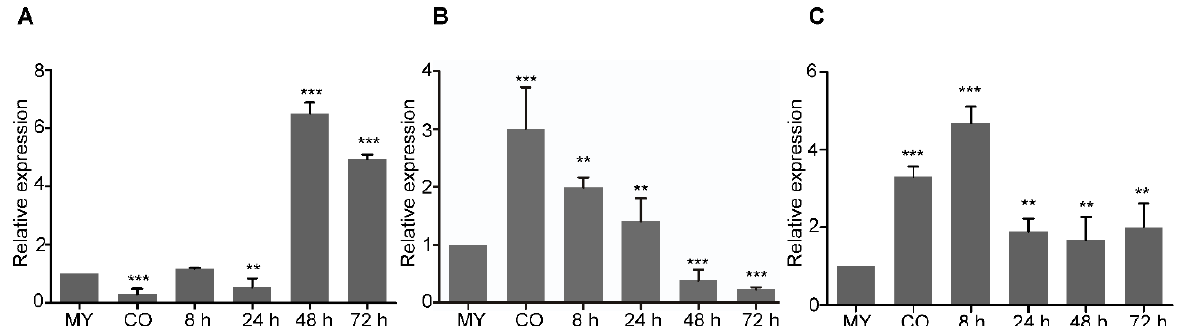
Figure 2. Phase-specific expression of the three MoGLN genes at various development stages of M. oryzae . ( A ) phase- specific expression of MoGLN1; ( B ) phase-specific expression of MoGLN2; ( C ) phase-specific expression of MoGLN3 . The phase-specific expression of the three MoGLN genes was quantified by quantitative real-time (QRT)-PCR after synthesis of cDNA in each developmental stage. The ACTIN gene (MGG_03982) was used for internal control for normalization, and the expression level of each gene at the mycelial stage was considered 1 for further comparisons. The qPCR results were obtained from three independent biological replications with three technical replicates. Error bars represent standard deviations. Asterisks indicate statistically significant differences (**, p < 0.01; ***, p < 0.001; one-way ANOVA was used to analyze data with Tukey’s multiple-comparison test in GraphPad Prism 8).